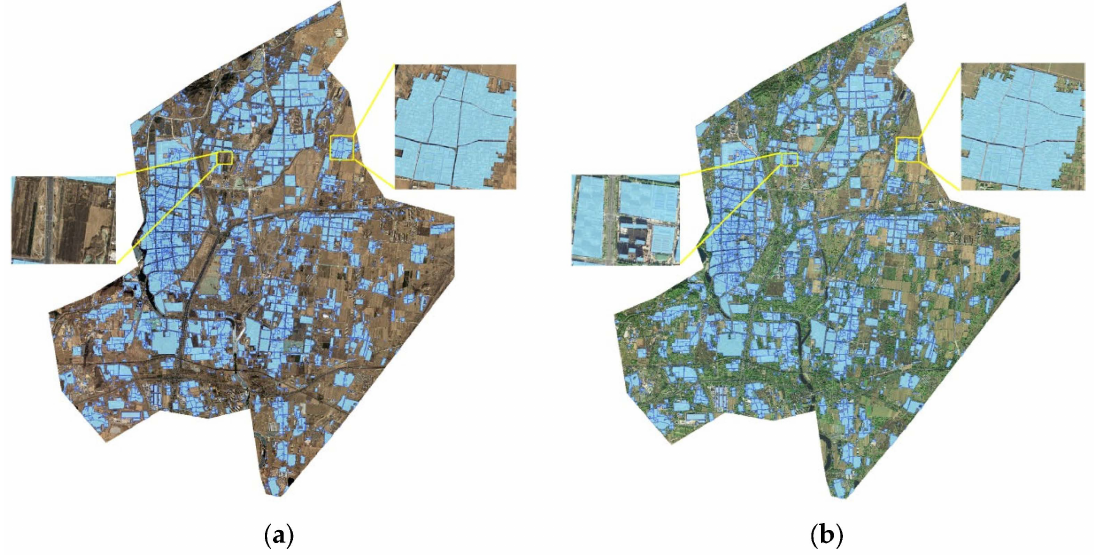
Figure 5. Beijing Huairou district land survey dataset, ( a , b ) show the images and the corresponding building labels for 2018 and 2019,